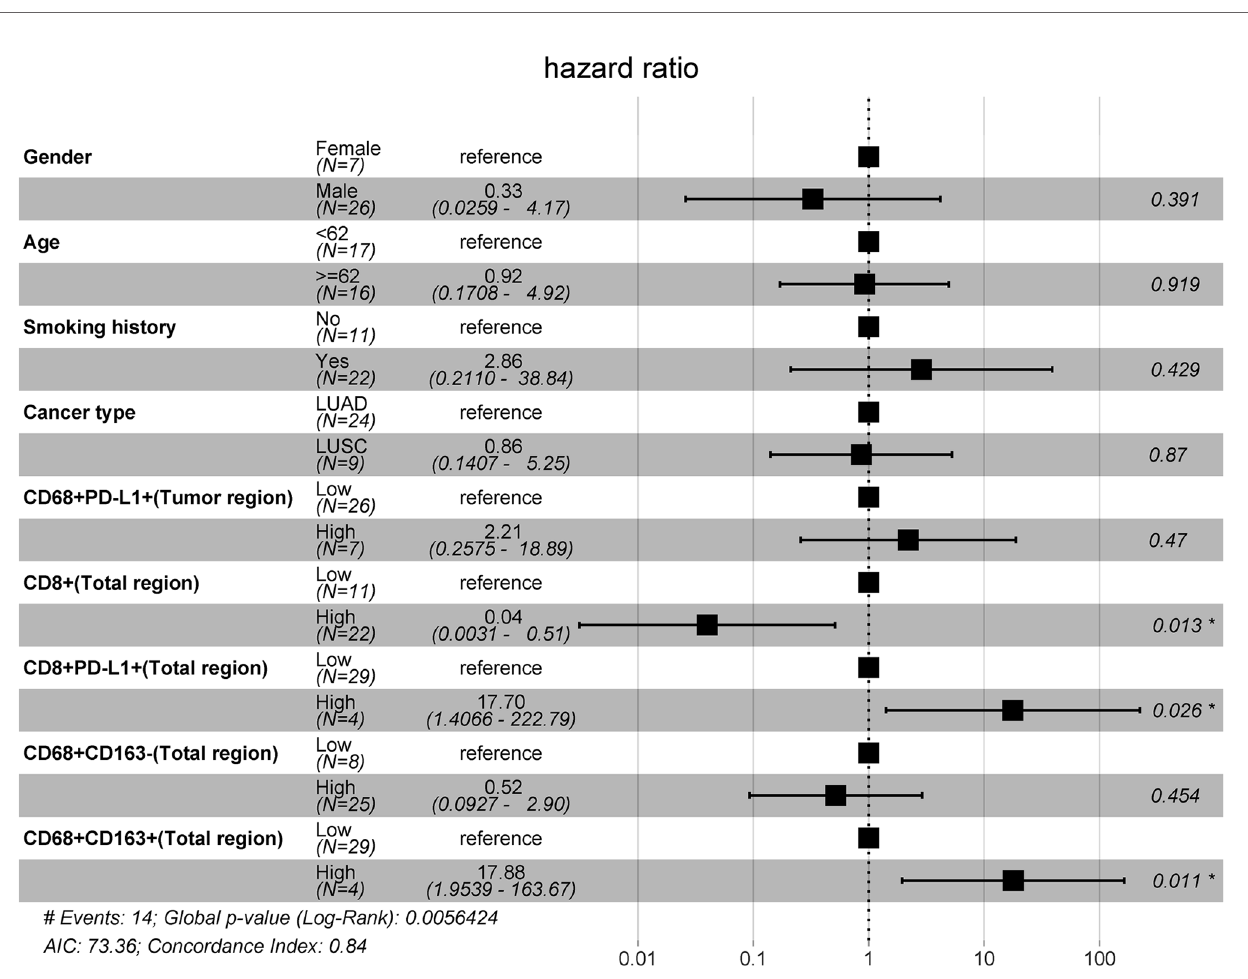
FIGURE 3 | Multivariate Cox model analyses of prognostic factors. The forest plot of multivariate survival analysis results indicates that the levels of in fi ltrating CD8+, CD8+PD-L1+, and CD68+CD163+ cells in the total region were independent prognostic markers for